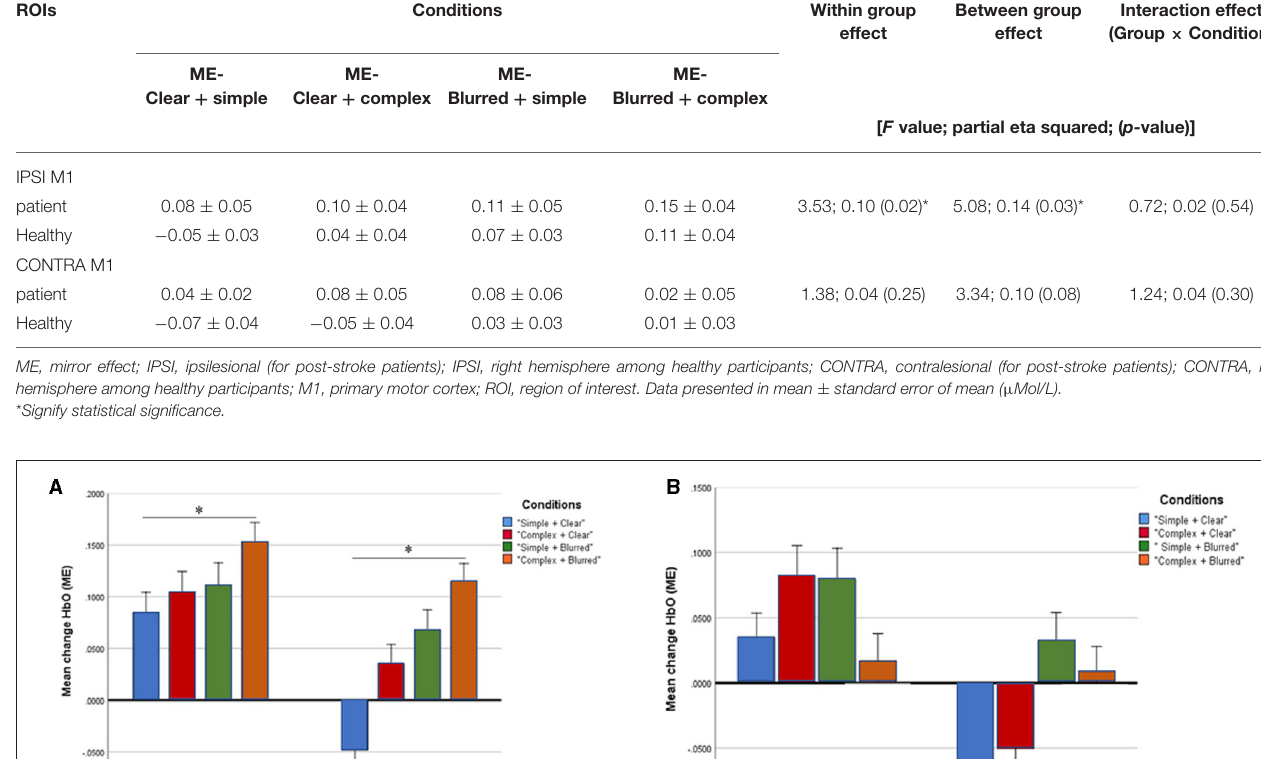
( Table 3 ; Figure 2B ). Figures 3B,D illustrate the changes in the HbO across 20 s in the contralesional/contralateral